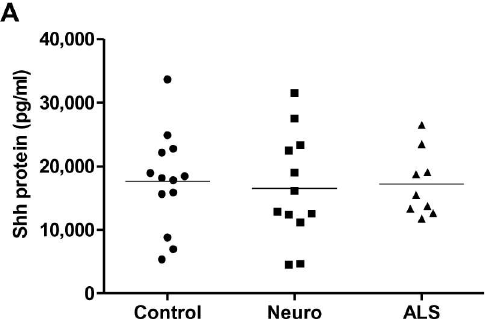
Fig 1. Direct measurement of Shh in CSF revealscomparable protein levels in ALS patients and controls. (A) Shh protein concentrations (pg/ml) in CSF samples are shown in normal controls (Control), neurological controls (Neuro), and patients with ALS (ALS). Protein concentrations were measuredby commercial ELISA kit as describedin Materialsand Methods. Standardwas preparedas per manufacturer’s protocol, and Shh protein levels were quantifiedbasedon standard curves obtained using ELISA reader. Detected Shh concentrations were17,195 ± 5,155 pg/ml in the ALS group, 17,624 ± 7,676 pg/ml in normal controls, and 16,480 ± 8,495 pg/ml in neurologicalcontrols that were not significantly different ( p = 0.89, normalcontrols versus